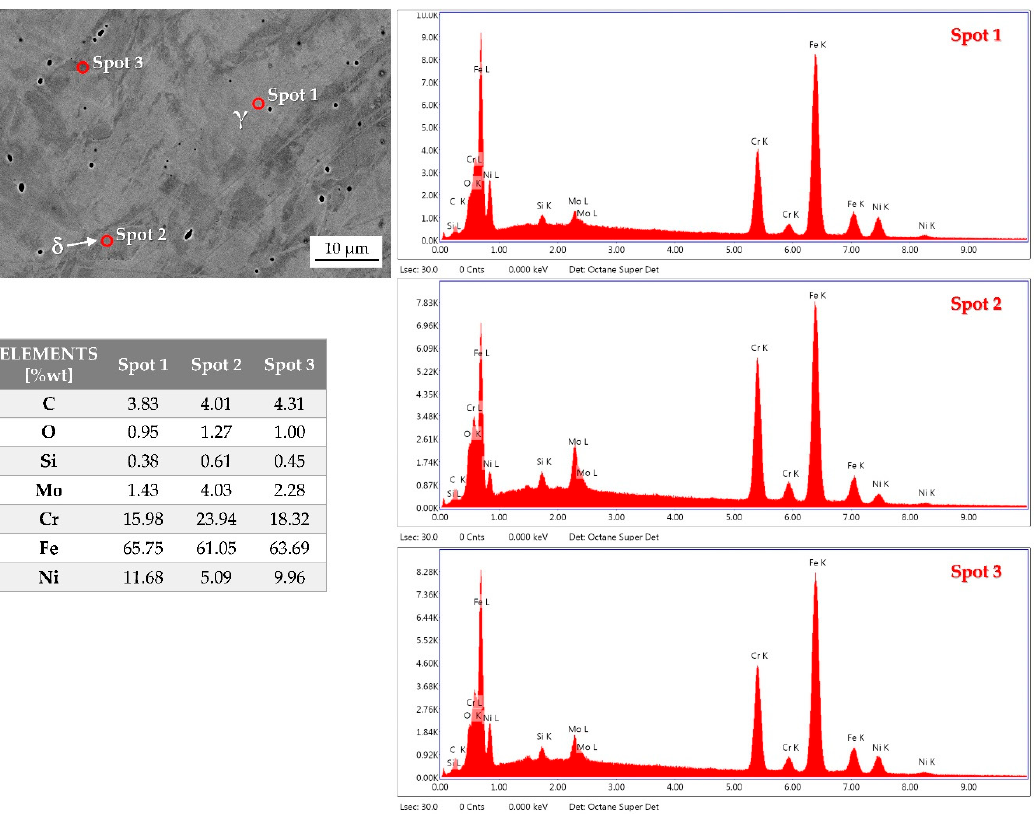
Figure 7. EDS–SEM image and the analysis of three spots in sample air-1.1.